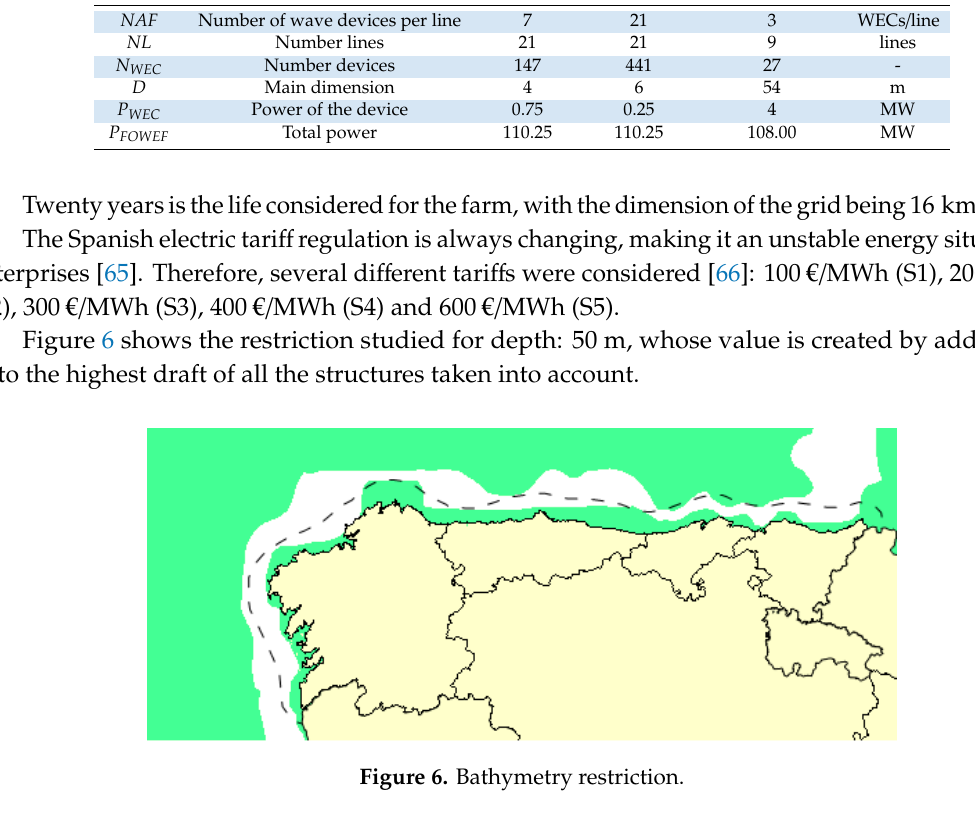
Table 1. Properties of the farms considering di ff erent converters.